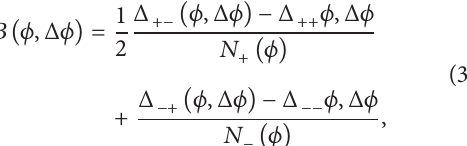
Figure 7: The balance functions in terms of 𝑞 Solid lines correspond to (28). The graph is taken from